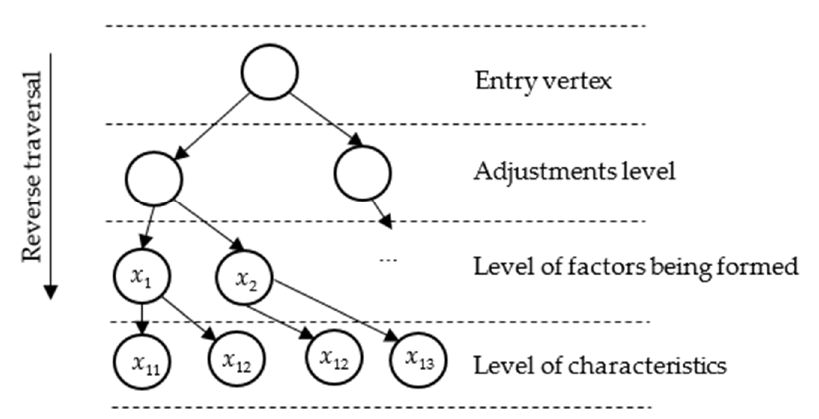
Figure 6. Adjustment tree.